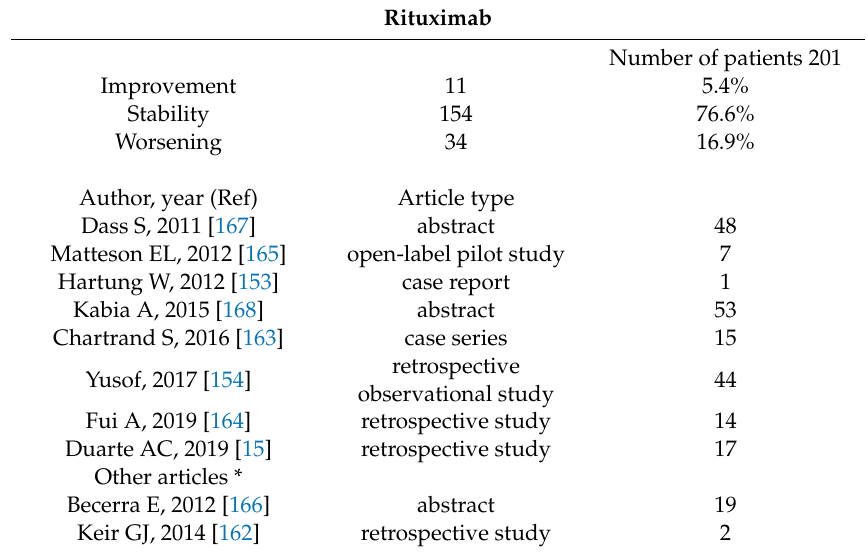
Table 7. Pulmonary e ff ects of rituximab in RA-ILD patients: a review of the